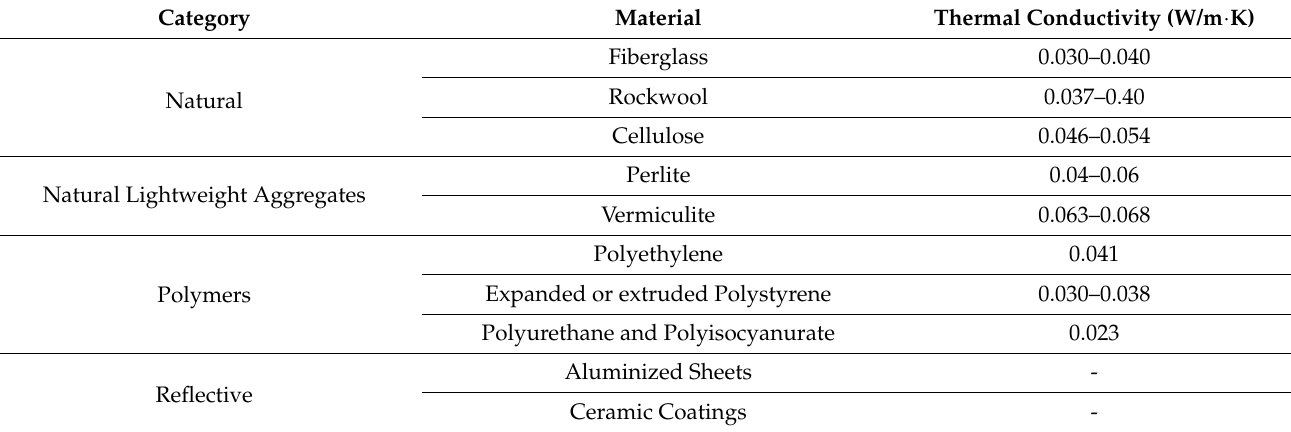
Table 3. Conventional types of insulation material (adopted from [10]).